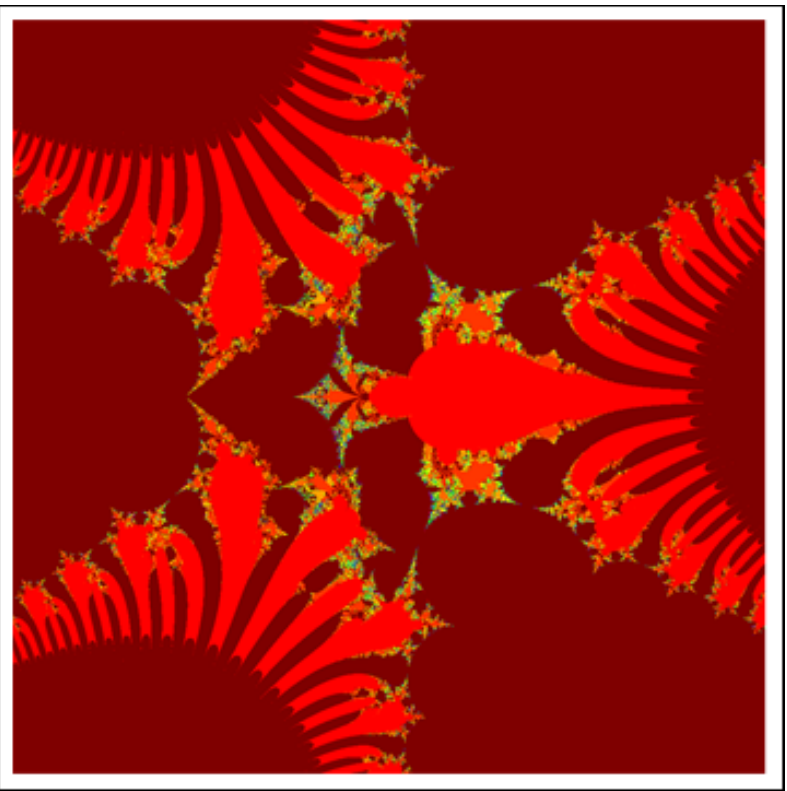
Figure 29. M-set for τ ( z ) = e z 3 + c via DKIS. The image execution time is 644.71